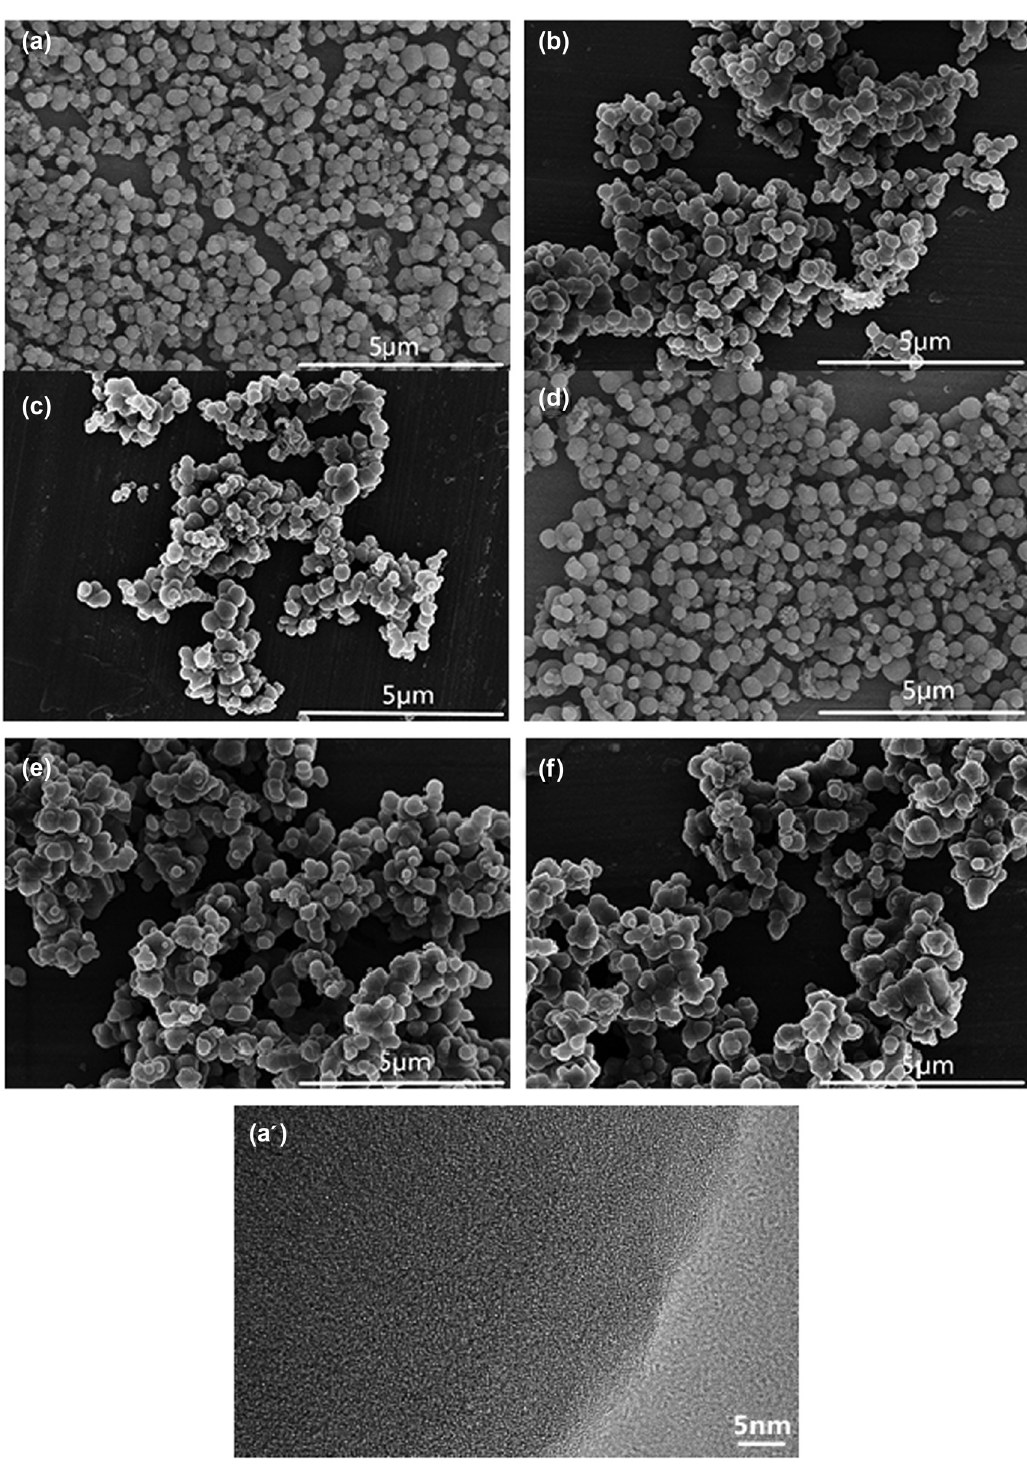
Figure 3: FESEM images of carbon microspheres prepared under di ff erent conditions and FETEM image of sample ( a ’ ) . Samples ( a – c ) were prepared at 90°C for 30 min with di ff erent concentrations of HCl: ( a ) 18.5%, ( b ) 25.9%, ( c ) 37.0%. Samples ( d – f ) were prepared at 90°C for 120 min with di ff erent concentrations of HCl: ( d ) 18.5%, ( e ) 25.9%, ( f )